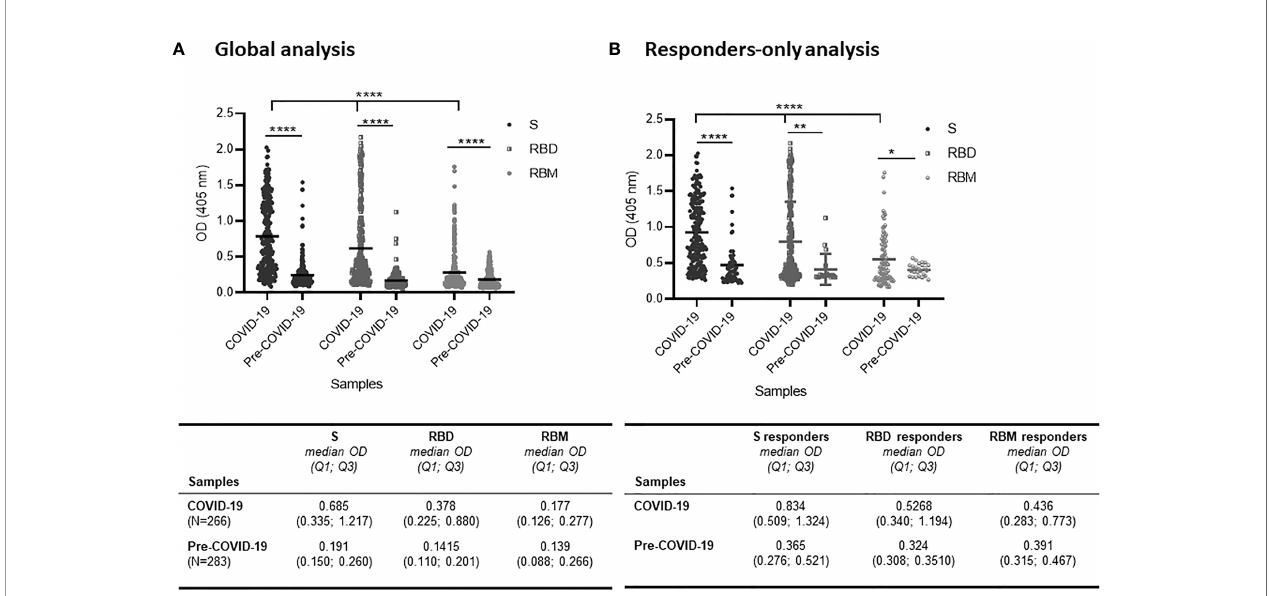
FIGURE 1 | Distribution of antibody responses against S, receptor-binding domain (RBD), and receptor-binding motif (RBM) antigens in COVID-19 and pre-COVID- 19 samples. (A) Global analysis of samples (positive and negative in ELISA) shows that antibody (Ab) levels (mean OD shown as a horizontal black line in the dot plots) for S, RBD, and RBM were signi fi cantly higher in COVID-19 patient samples as compared to pre-COVID-19 donor samples ( p < 0.0001). Also, the Ab levels varied signi fi cantly ( p < 0.0001) among S, RBD, and RBM in COVID-19 samples. The table shows the median OD, Q1, and Q3 values of antibodies for S, RBD, and RBM in COVID-19 and pre-COVID-19 samples. (B) Levels of Ab responses in responder-only COVID-19 samples were signi fi cantly higher than in responder-only pre-COVID-19 samples (cross-reactive responders) for S ( p < 0.0001), RBD ( p < 0.01), and RBM ( p < 0.05). The table shows the median OD, Q1, and Q3 of antibodies for S, RBD, and RBM of responder-only samples in COVID-19 and pre-COVID-19 participants. The unpaired t-test and ANOVA were performed to compare the mean ODs of antibodies between the two groups and within the groups themselves, respectively. * p < 0.05; ** p < 0.01; **** p < 0.0001; OD, optical density; Q1, quartile 1; Q3, quartile